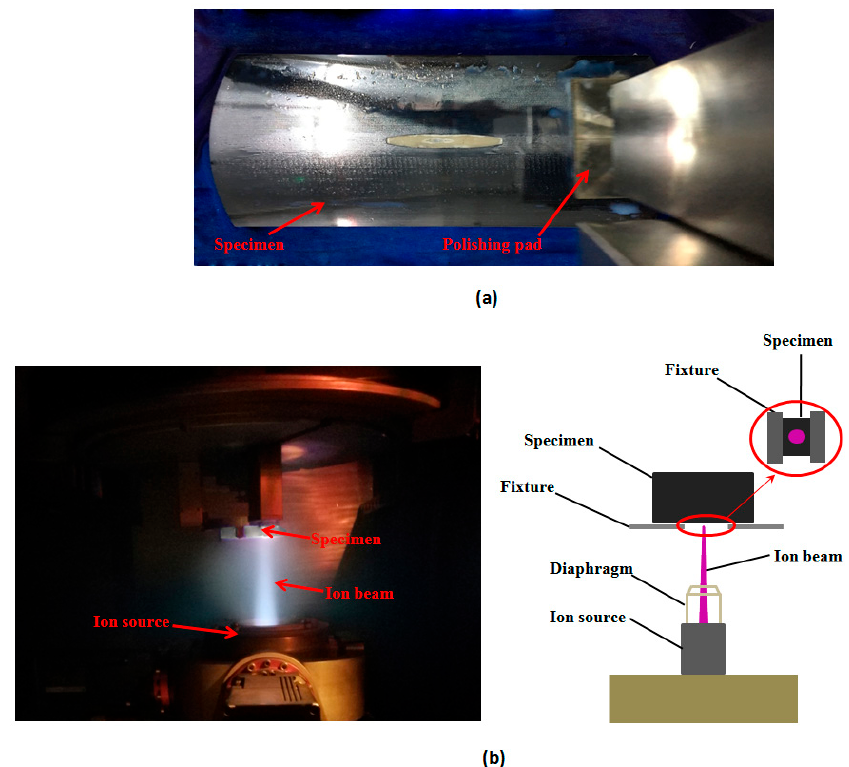
Figure 1. Postprocessing of single crystal silicon mirror: ( a ) computer-controlled optical surfacing (CCOS) processing and ( b ) ion beam etching (IBE) processing.